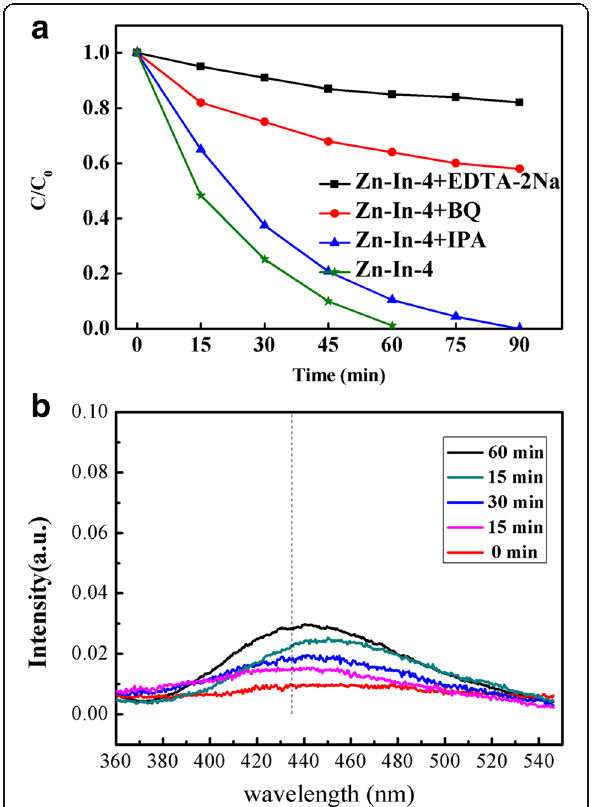
Fig. 8 Recycling experiments of solar light photocatalytic degradation of MO ( a ) and 4-NP ( b ) over the Zn-In-4 Fig. 9 Trapping experiment of active species during the photocatalytic degradation of MO over Zn-In-4 under solar light irradiation ( a ) and the OH-trapping PL spectra over Zn-In-4 sample ( b